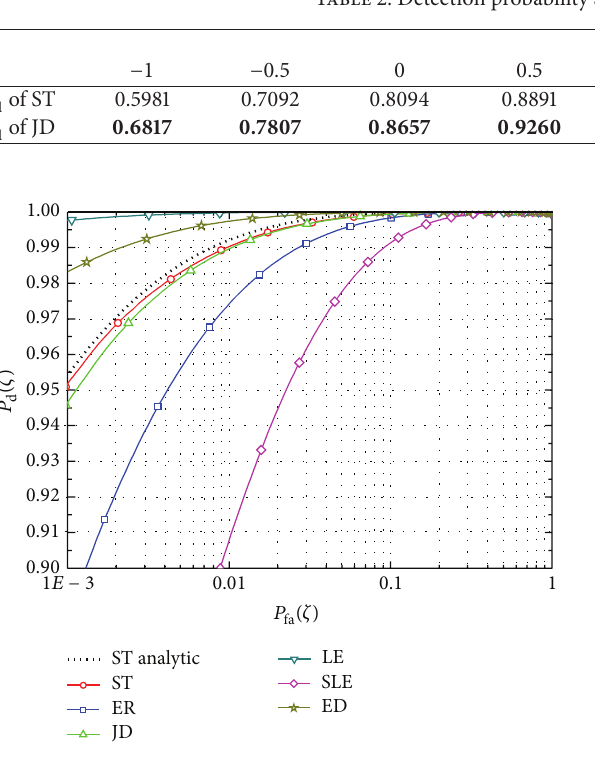
Table 2: Detection probability as a function of SNR 1 using (21).